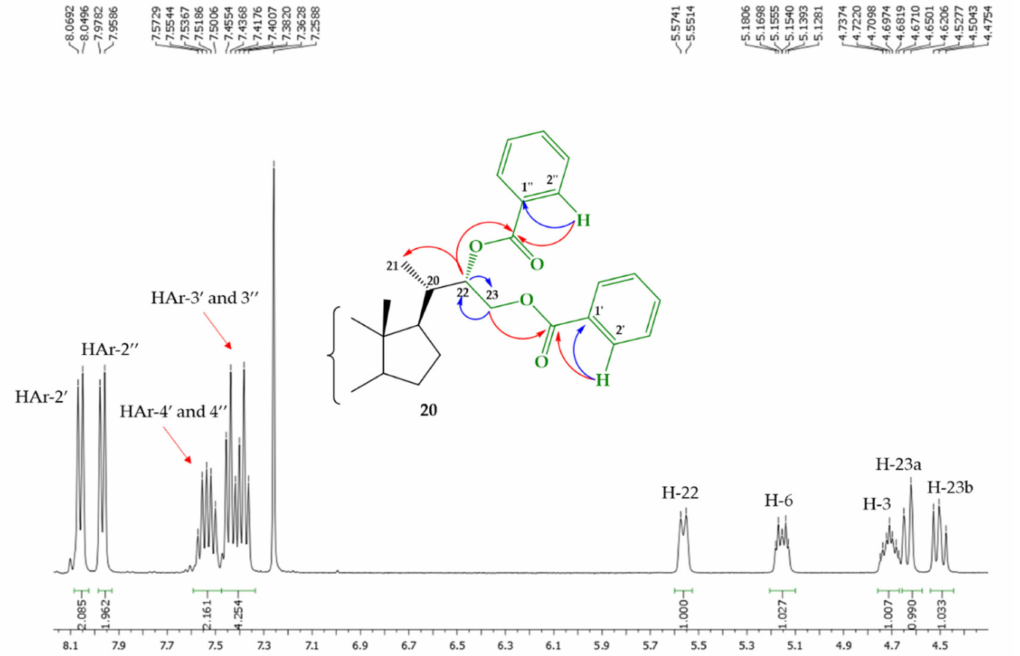
Figure 5. Amplification zone 8.15–4.45 ppm of 1 H NMR for dibenzoylated derivative 20 and the main heteronuclear correlations 2D HMBC to 2 J CH (blue) and 3 J CH (red) observed for 20 , which confirm the positions of both benzoate groups in C22 and C23 of the side chain. HAr-2 (cid:48) ; HAr-2”, HAr-4 (cid:48) , and HAr-4”; HAr-3 (cid:48) and HAr-3” are hydrogen atoms in the aromatic